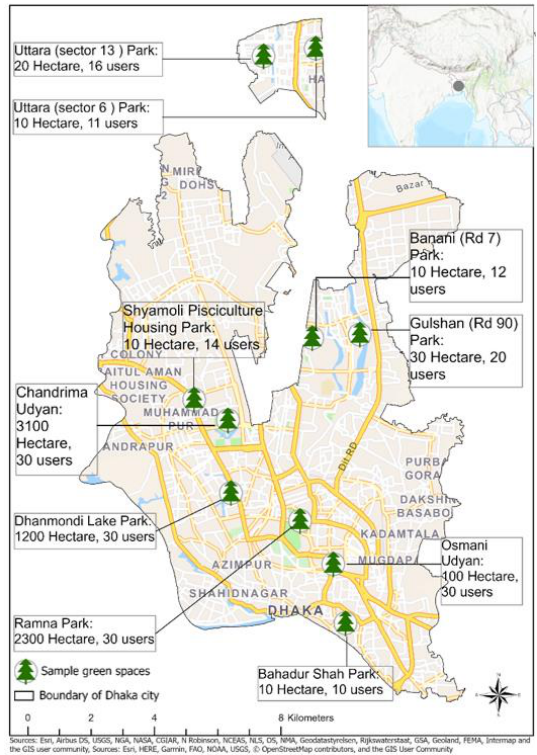
Figure 1. Study area location and studied green spaces in Dhaka.